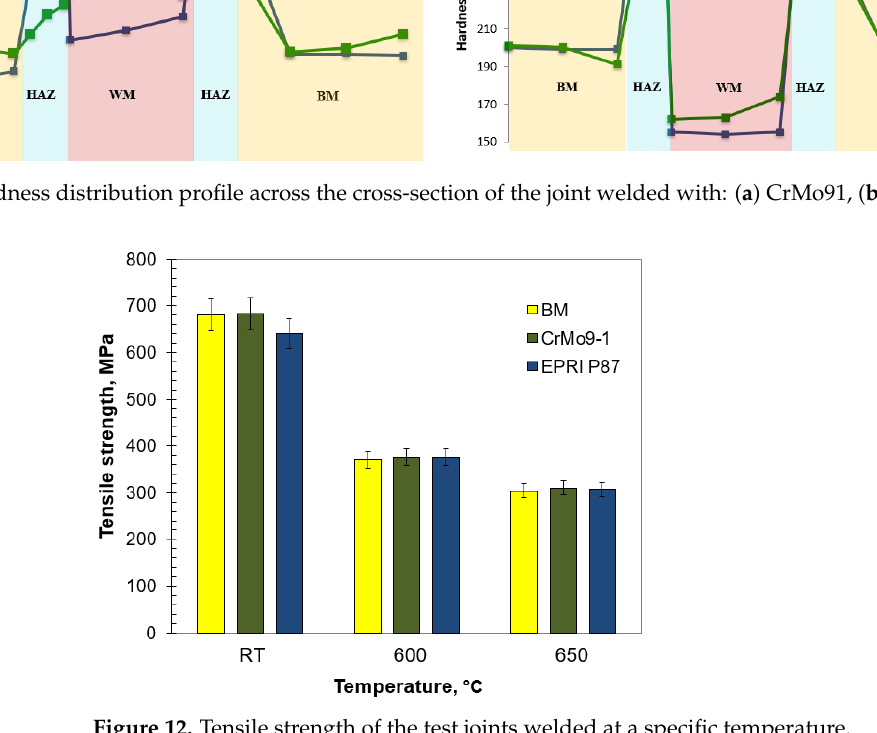
Figure 12. Tensile strength of the test joints welded at a specific temperature.